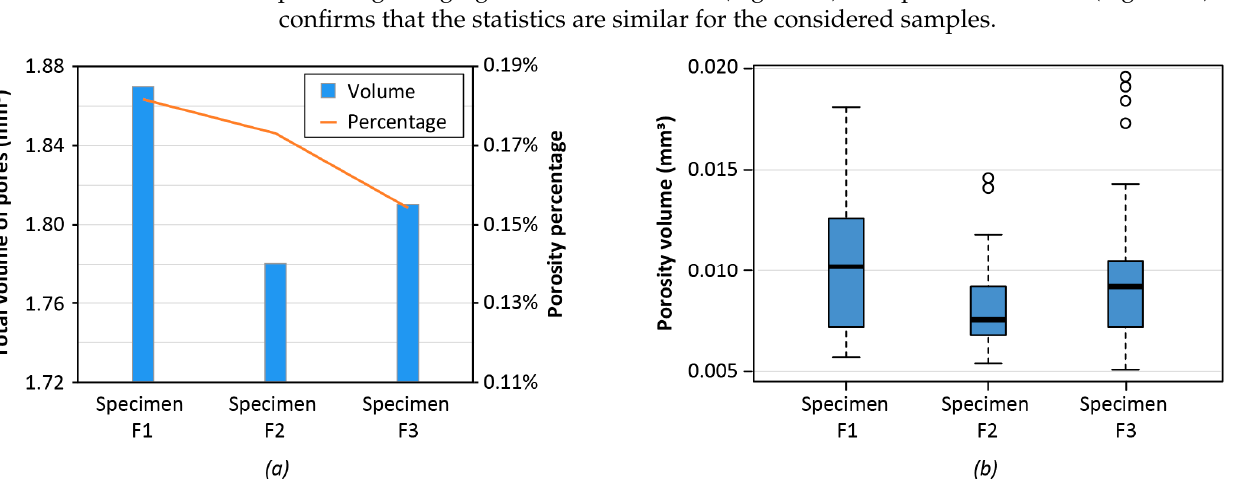
Figure 7. Porosity analysis of 3 dumbbell specimens: ( a ) total volume of pores for 3 different tensile samples produced with LS printing set and 25% infill; ( b ) distribution of porosity volume at varying EM (excluding pores with volume lower than 0.005 mm 3 and higher than the 99th percentile).